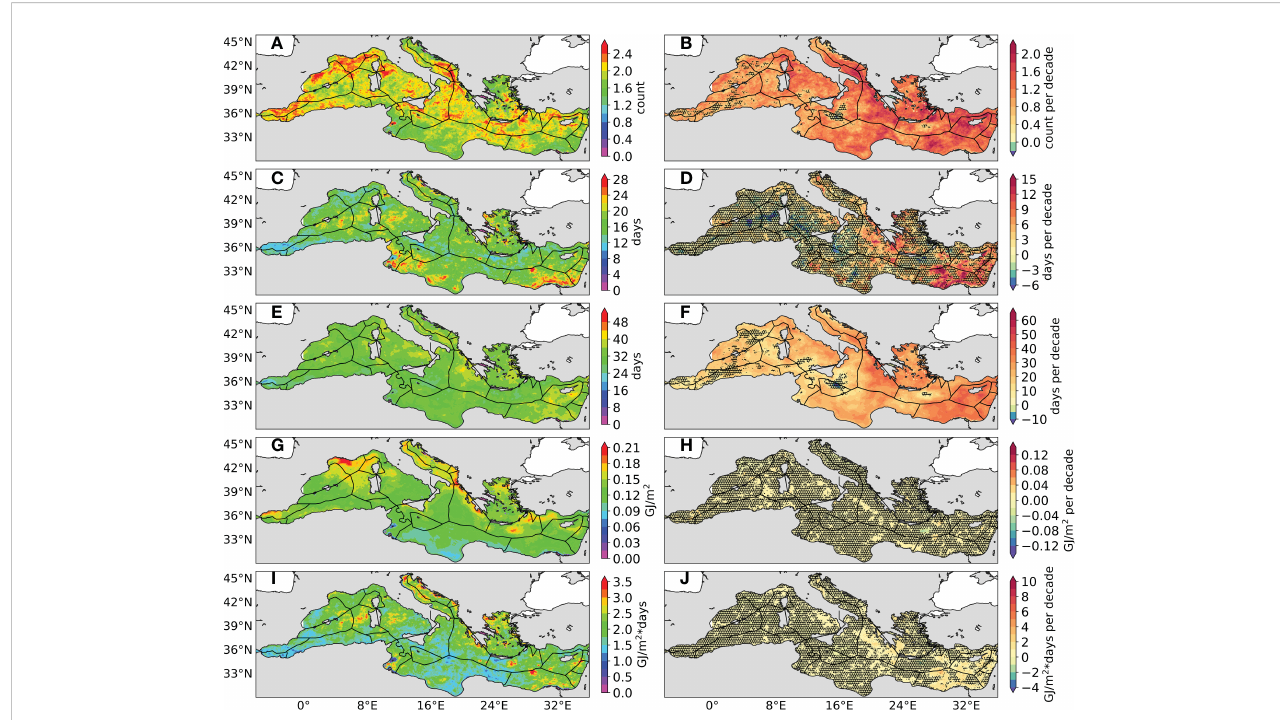
FIGURE 3 Means (left panels, A, C, E, G, I ) and linear trends (right panels, B, D, F, H, J ) from REP over the period 1987-2019 of annual MHW frequency ( A, B, in count), duration ( C, D, in days), total days ( E, F, in days), maximum intensity ( G, H, in °C) and cumulative intensity ( I, J , °C*days). The black hatches indicate where trend values are not signi fi cant at the 95% con fi dence level based on a Mann-Kendall trend test.